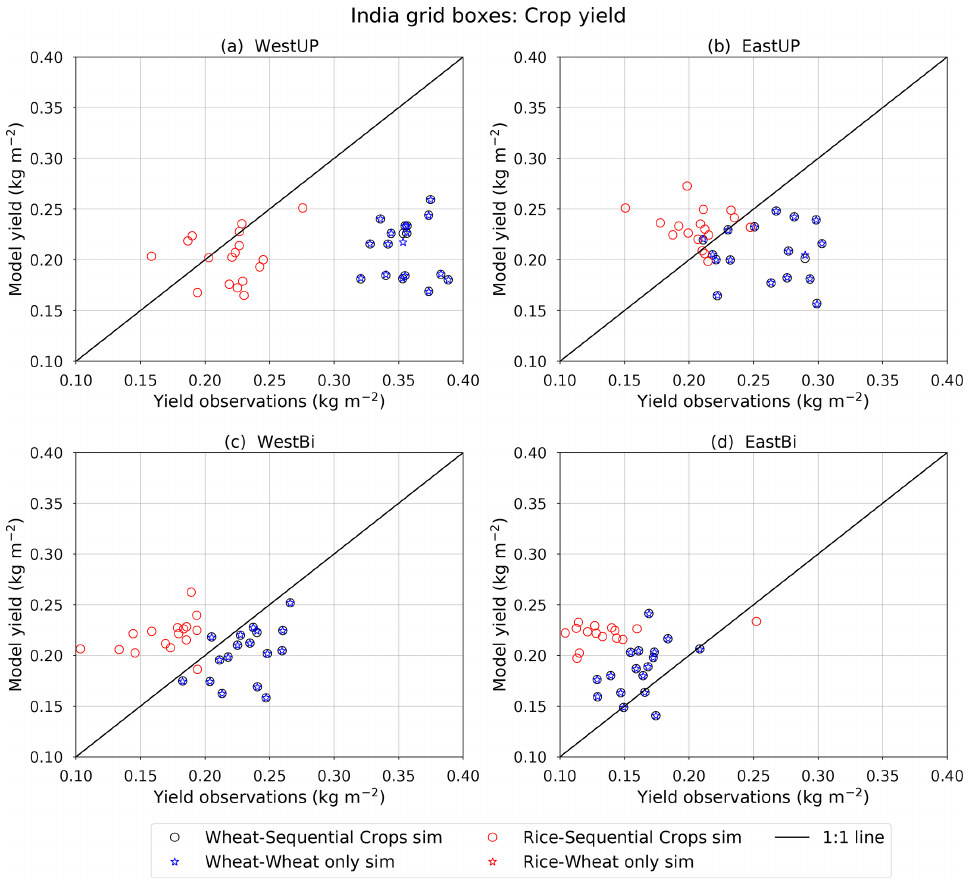
Figure 6. Scatter plot comparing the observed rice and wheat yields (ICRISAT, 2015) against JULES simulations at each of the India locations shown in Fig. 3, with India-sequential shown by circles (rice in red and wheat in black). India-single shown by asterisks (rice shown in red and wheat shown in blue). Note that the simulations assume that rice and wheat are grown everywhere and the crops are not limited by pests and diseases or nutrient availability, which will affect the comparison with the observations that implicitly include these